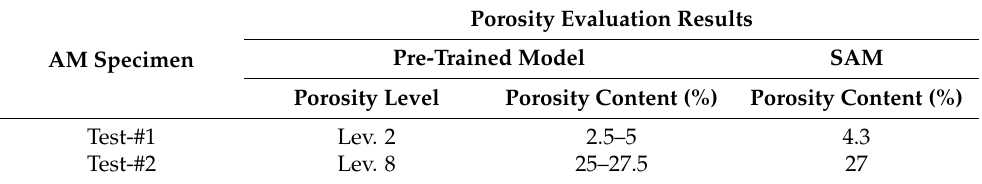
Table 7. Comparison of the results obtained with the pre-trained model and